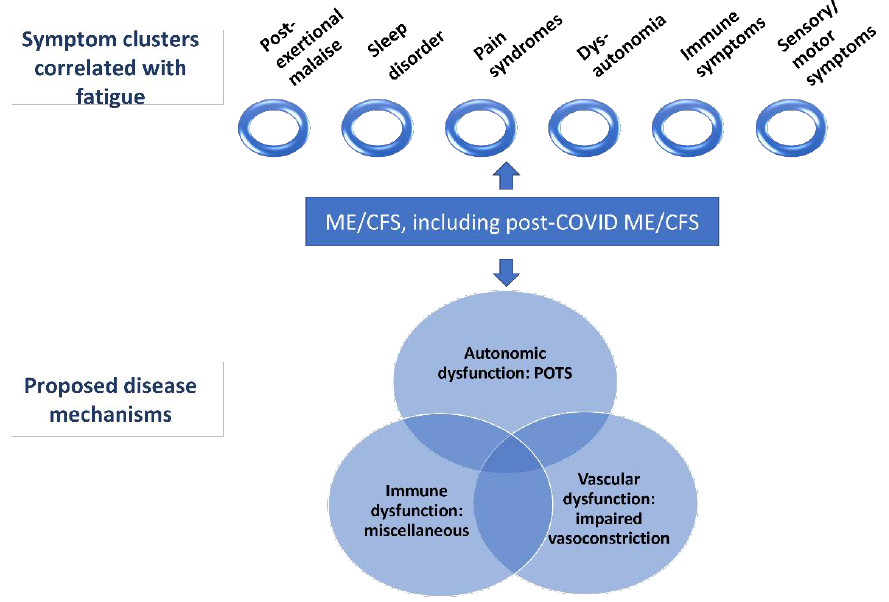
Figure 4. Visual summary of the main findings of the article. ME/CFS — myalgic encephalomyeli- tis/chronic fatigue syndrome, POTS — postural orthostatic tachycardia syndrome.